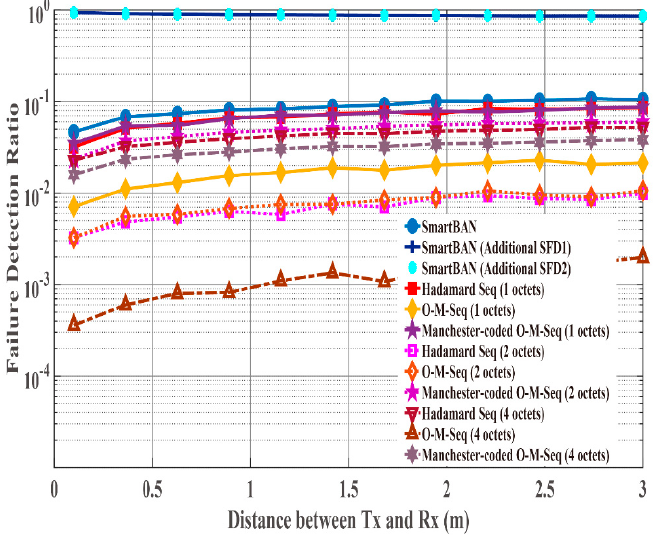
Figure 11. Computational complexity for preamble detection.